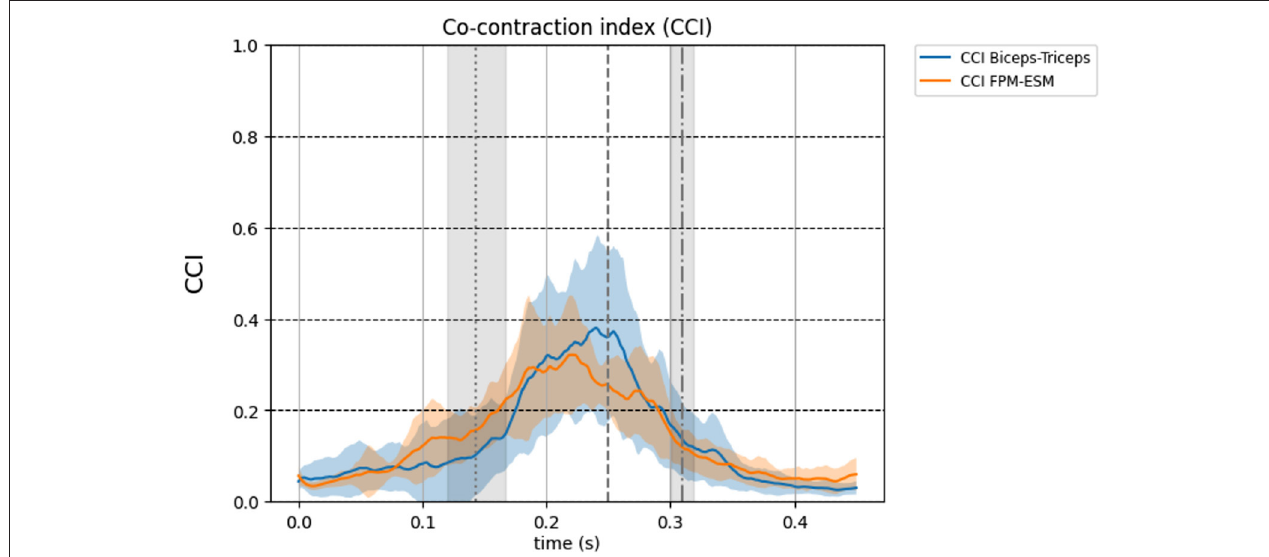
FIGURE 3 | Group level of the co-contraction index of the elbow muscles during pitching corrected for EMD (50ms). The thick line shows the mean over all 11 participants and standard deviation is shown as transparent area around the mean. Blue line: CCI Biceps-Triceps, orange line: CCI FPM-ESM. The three vertical lines represent FC (dotted), MER (dashed), and BR (dot dashed), respectively. Be aware: the co-contraction index ranges from 0 till 2, here the y-axis scale ranges from 0 to 1 for better visualization.